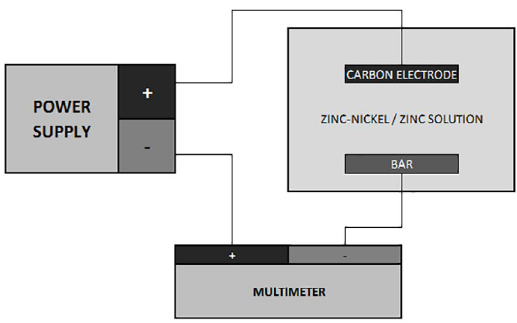
Figure 1. Methodology used for rebar electroplating